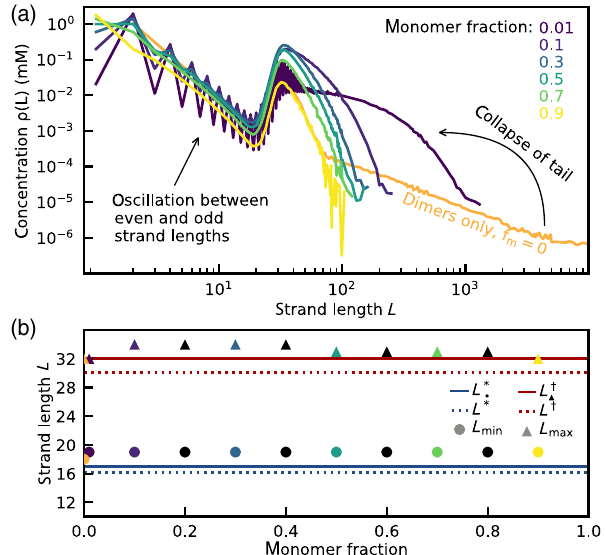
FIG. 13. (a) Length distributions for monomer-dimer mixtures. The monomer fraction f m is varied between zero and 90% at a total 2 mM. For low f concentration c m the concentration between tot ¼ even and odd strands oscillates heavily for short strands. The long tail that is present for f m ¼ 0 (orange curve, only even strand FIG. 14. Pure primer extension (a) versus duplex extension (b), lengths shown) collapses even for very small f m . (b) L (cid:1) in the (c). The overhang at the beginning of a (partial) trajectory is monomer-dimer system is calculated via Eq. (D4), which is the called a copy site (blue) with length l . (b) In primer-template cs same as the formula for the dimer-only system upon substituting switching events a building block extends the primer beyond the the dimer concentration with the total concentration c . original copy site. The original copy site is fully covered and a tot new copy site is formed. The roles of primer and template are exchanged. (c) Copy sites can grow independently of the original primer by template extension with the help of a helper strand. (d) The number of extension events occurring during the covering − l of the total copy site C split according to different final initial types of